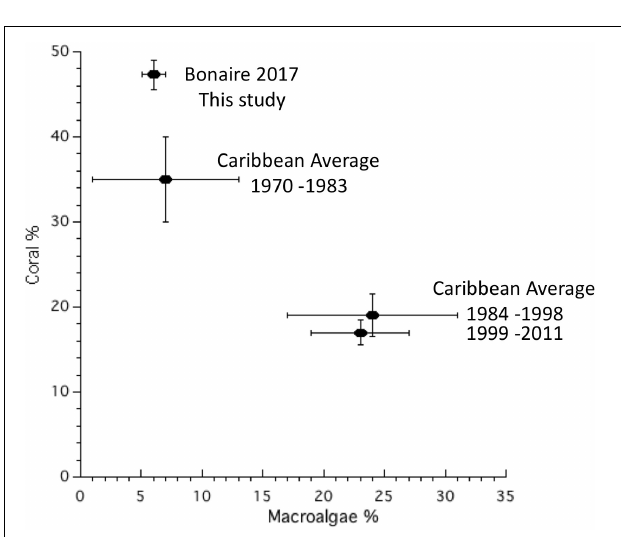
FIGURE 10 | Comparison of mean coral and macroalgal abundance for Bonaire and the rest of the Caribbean between 1970 and 2011 (from Jackson et al.,